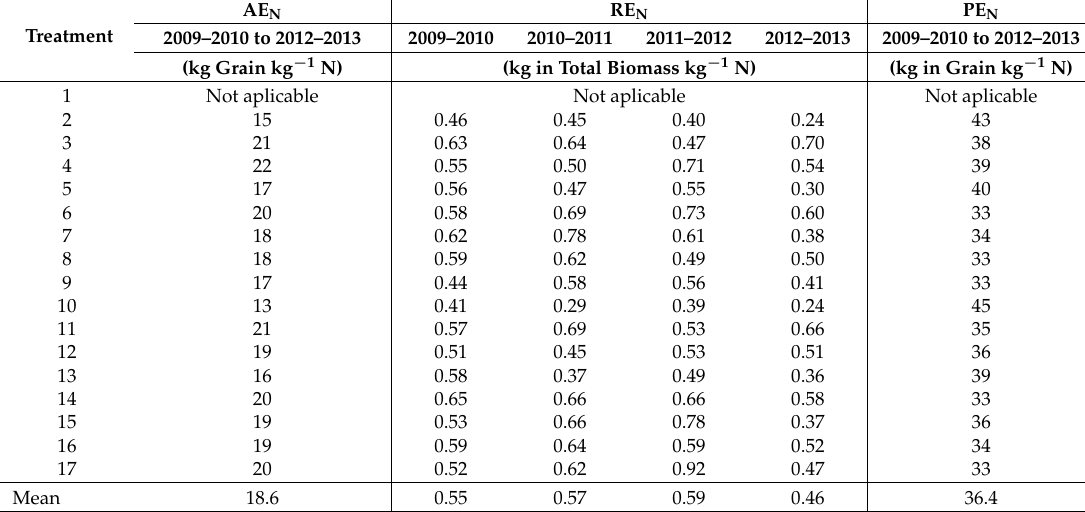
Table 6. Means of nitrogen (N) agronomic efficiency (AE N ), crop recovery efficiency of applied N (RE N ), and physiological efficiency of applied N (PE N ), as influenced by selected treatments composed of urea sources, timing and method of fertilizer application at the International Maize and Wheat Improvement Center (CIMMYT), in the Yaqui valley, near Ciudad Obregon, Sonora, Mexico. AE N RE N Treatment